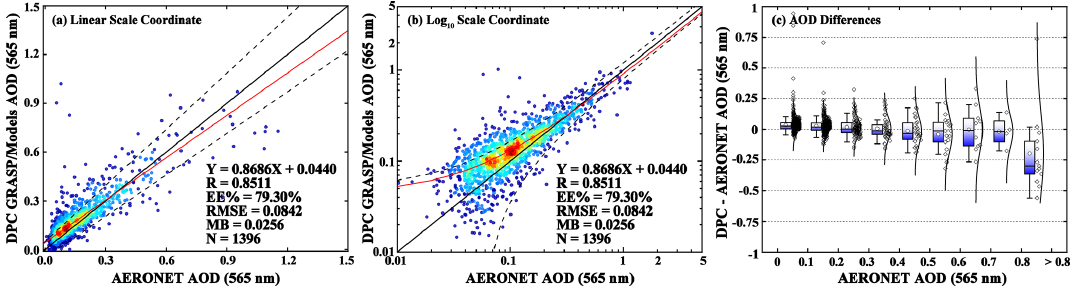
Figure 2. (a) Density scatterplot of AOD retrievals from DPC with the GRASP/Model scheme versus the AERONET observations with a linear coordinate system. (b) The density scatterplot with a logarithmic coordinate system. The solid black line is the one to one value and the dashed black lines show the ranges of expected error. The solid red lines represent the linear regression line. (c) Box plots show changes in differences between DPC GRASP/Model and AERONET with AOD increasing. Diamonds and curves represent distributions of samples and normal distribution fitting lines, respectively.